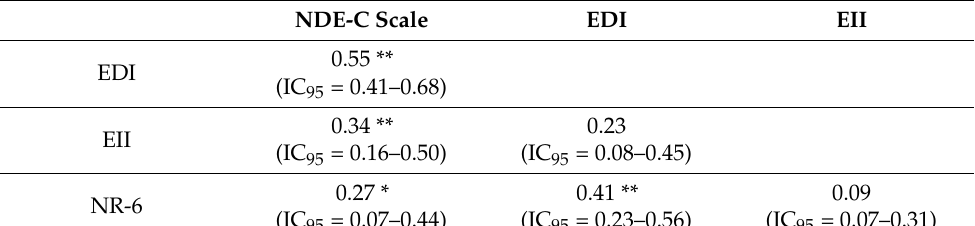
Figure 2. Association between the Near-Death-Experience Content (NDE-C) scale total scores and the Ego-Dissolution Inventory (EDI) total scores within the classical NDE and NDE-like experiencers (r = 0.55, IC 95 = 0.41–0.68, p < 0.001). Table 3. Spearman rank correlations between total scores of all questionnaires ( n = 100). * p < 0.008; ** p < 0.001.